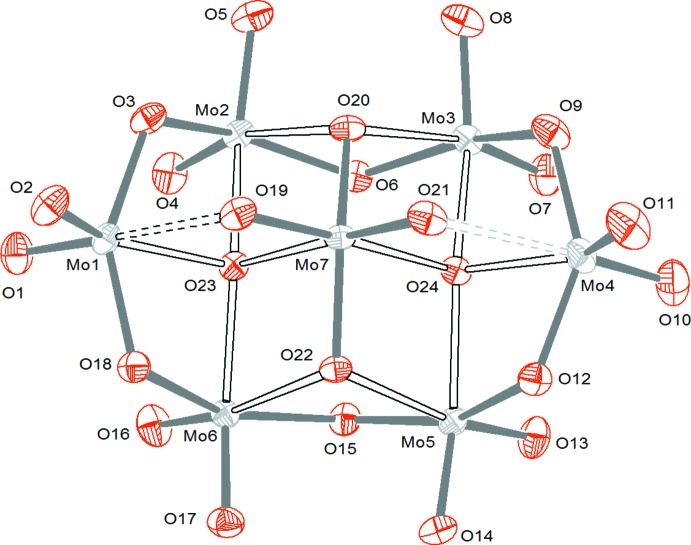
Mol­ecular structure of the [Mo7O24]6− hepta­molybdate cluster anion in (I).